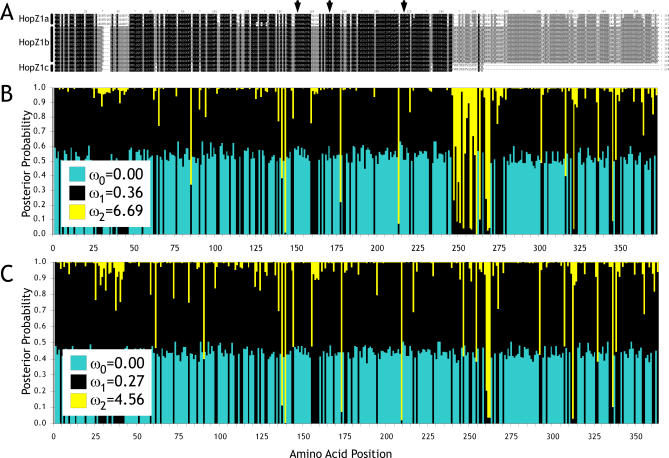
PAML Selection Analysis(A) Amino-acid alignment of the HopZ1 alleles. See Figure S3 for details. The three amino acids in the catalytic triad are indicated by arrows presented above the alignment.(B) Stacked histogram representing the posterior probabilities for the three site classes identified by codeml model M3 (discrete) along the HopZ1 sequence for all functional alleles. The dN/dS (ω) values for each site class are given below the figure.(C) Same as above but using only hopZ1a and hopZ1b to remove the signal from the frameshift mutation in hopZ1c.